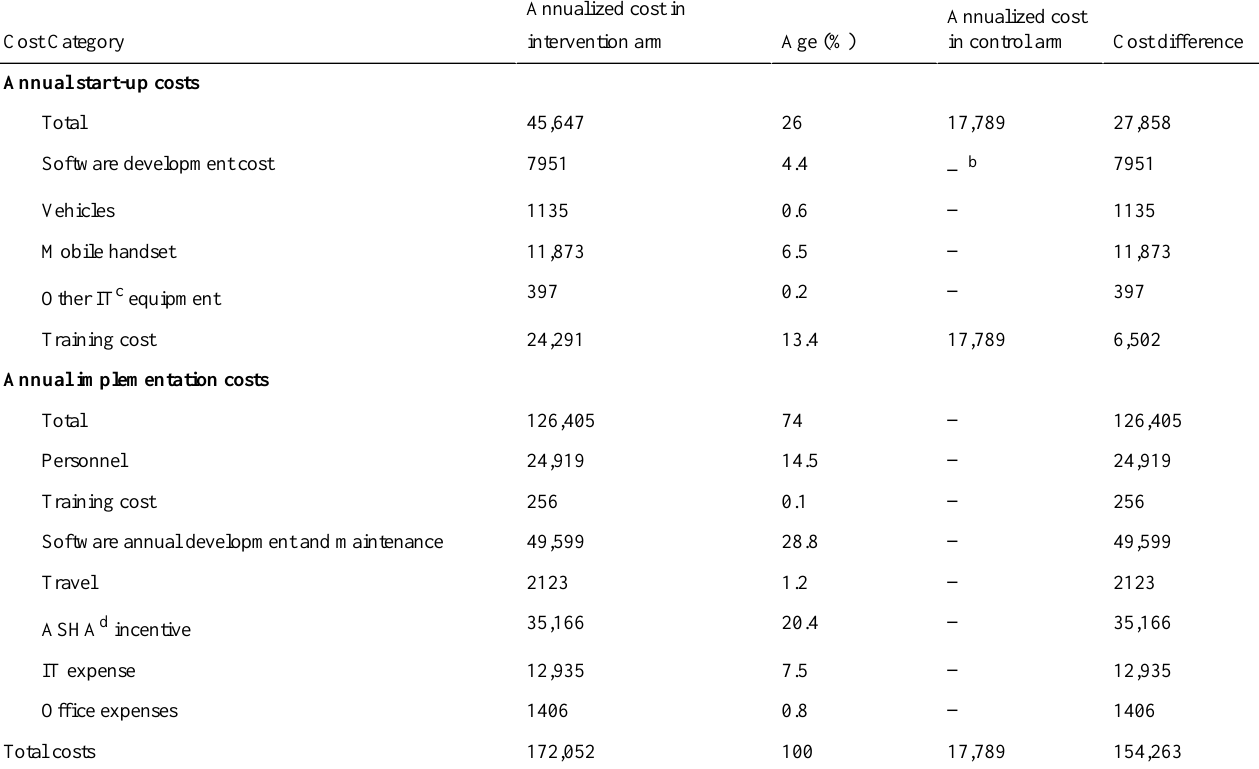
Table 1. Annual start-up and implementation costs (US dollars) of the ImTeCHO a program in the implementation and control arms from a program